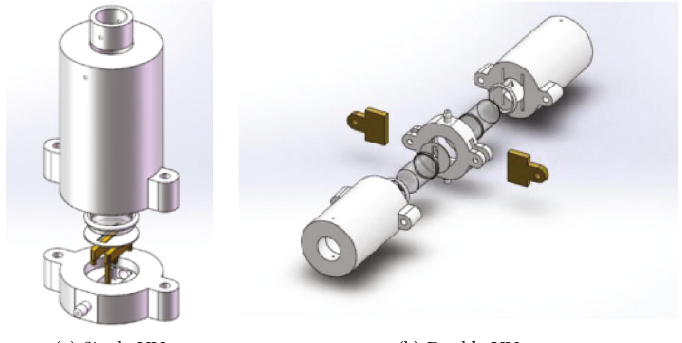
Figure 1: The PID detector